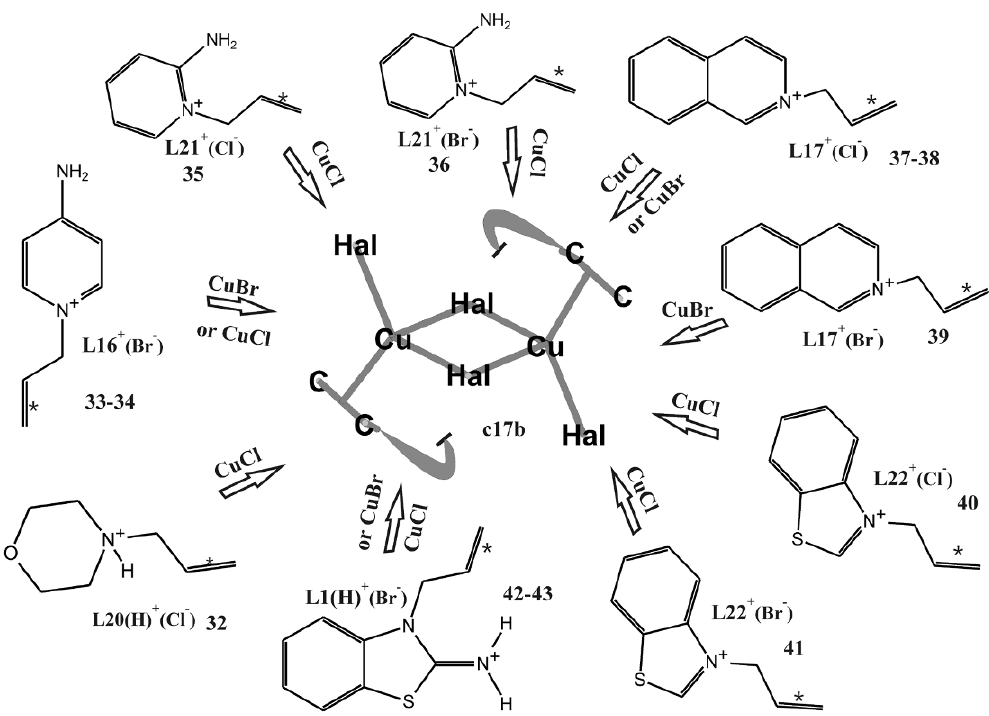
Figure 8. Structural genesis of C17 fragment in 32-43